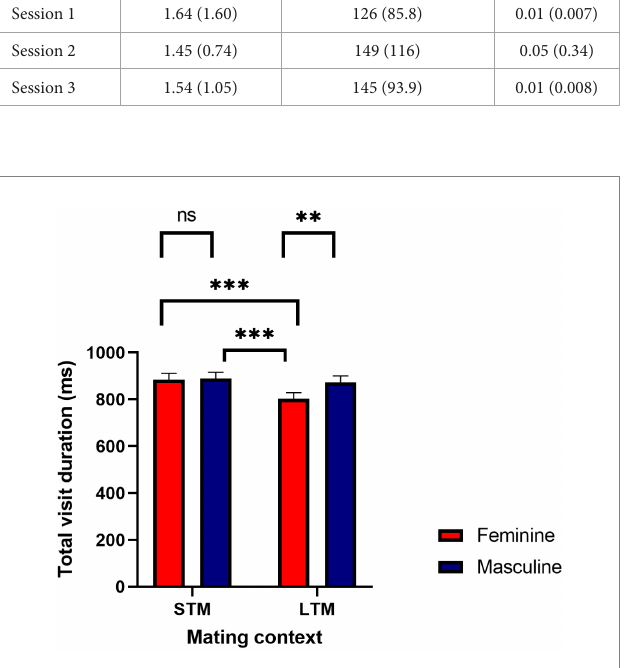
FIGURE 3 Women’s total visit duration in milliseconds as a function of facial masculinity and mating context. * p < 0.05, ** p < 0.01, *** p < 0.001.